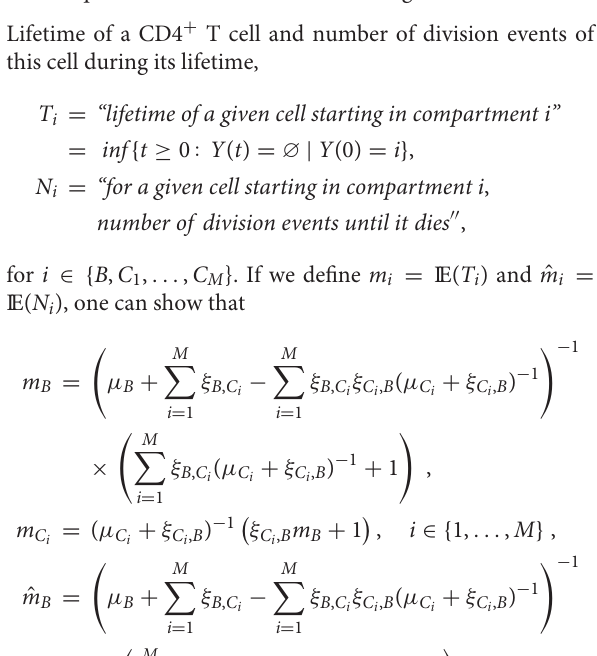
, ξ C ), j ∈ { 1, ... , M }} . Division events are represented by j j , B , j ∈ { 1, ... , M }} , j